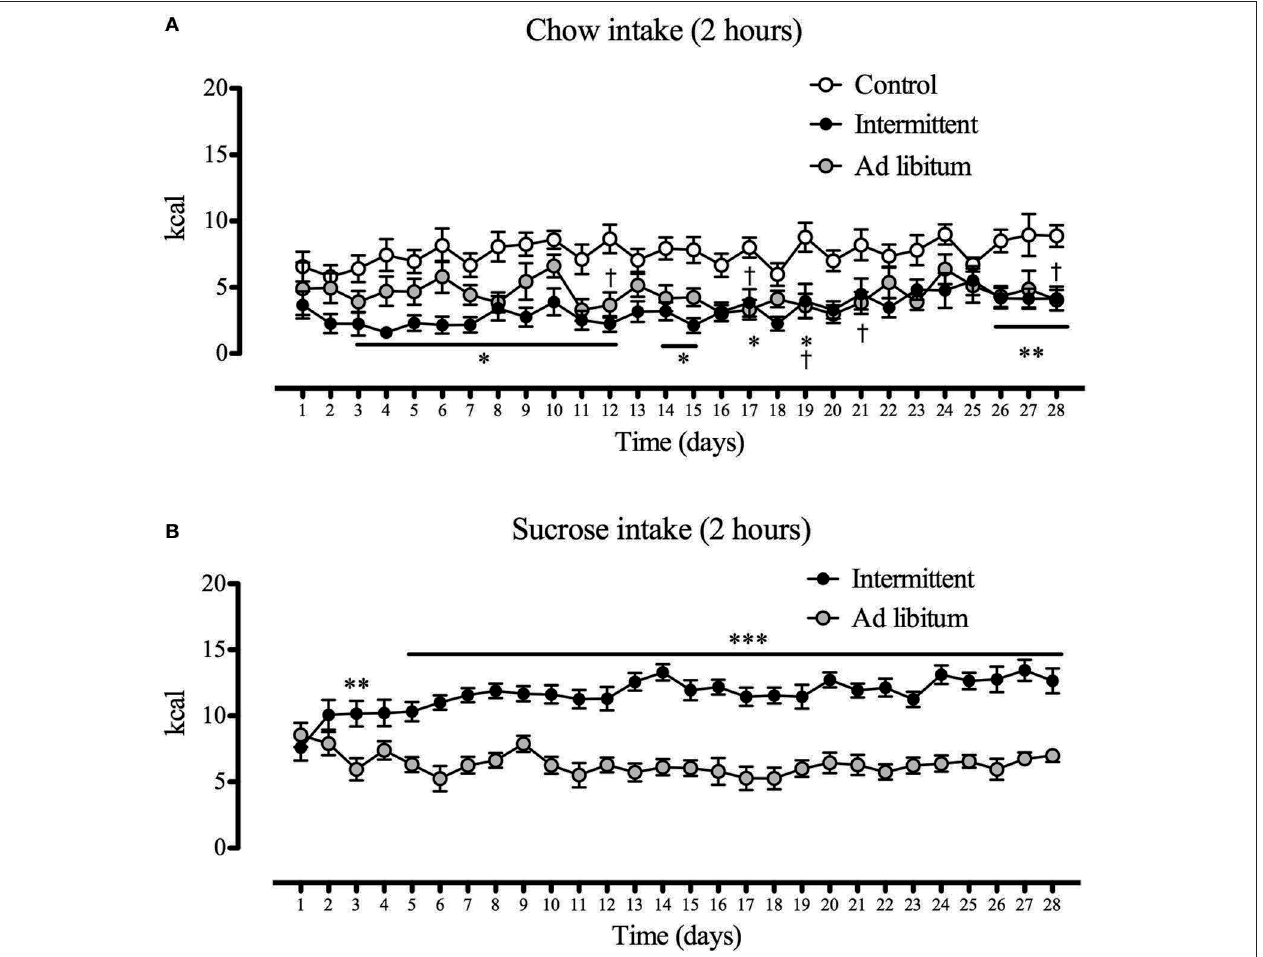
FIGURE 3 | Daily energy intake from chow (A) and from the sucrose solution (B) of animals during the 28 days of exposition to the sucrose solution (control, n = 14; intermittent, n = 16; ad libitum , n = 13). Food and sucrose solution intake were measured in grams during a 2-h period, converted to kcal and expressed as means ± S.E.M. (A) * p < 0.05, ** p < 0.01 intermittent group vs. control group; † p < 0.05 ad libitum vs. control group. (B) ** p < 0.01, *** p < 0.001 intermittent group vs. ad libitum